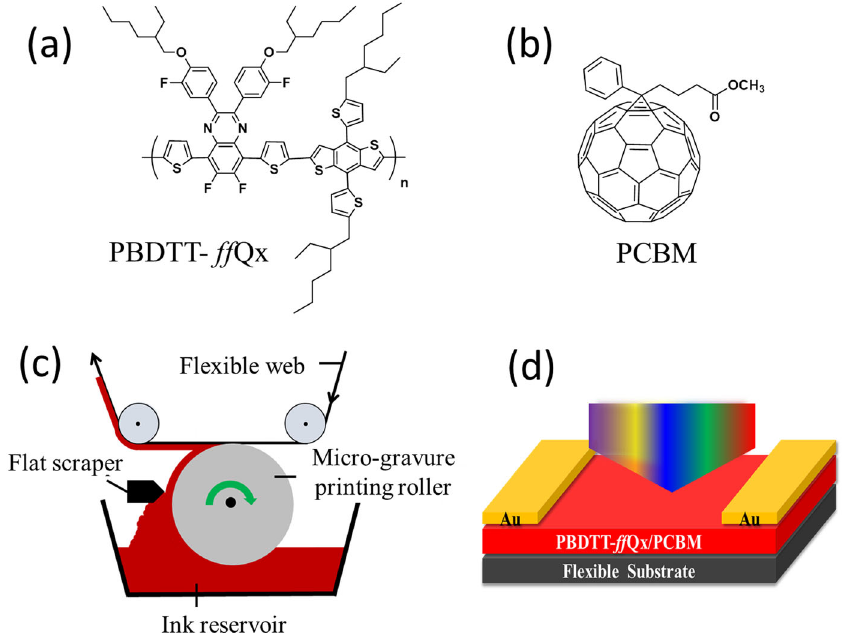
Fig. 1 Chemical structures of a PBDTT- ff Qx and b PCBM. c Schematic of micro-gravure printing process. d Schematic con fi guration of the PBDTT- ff Qx/PCBM BHJ